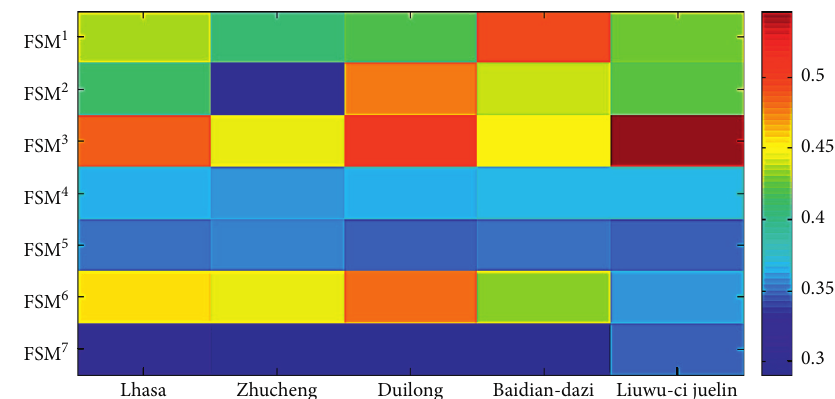
Figure 1: Comparative analysis of single-dimensional travel deprivation.